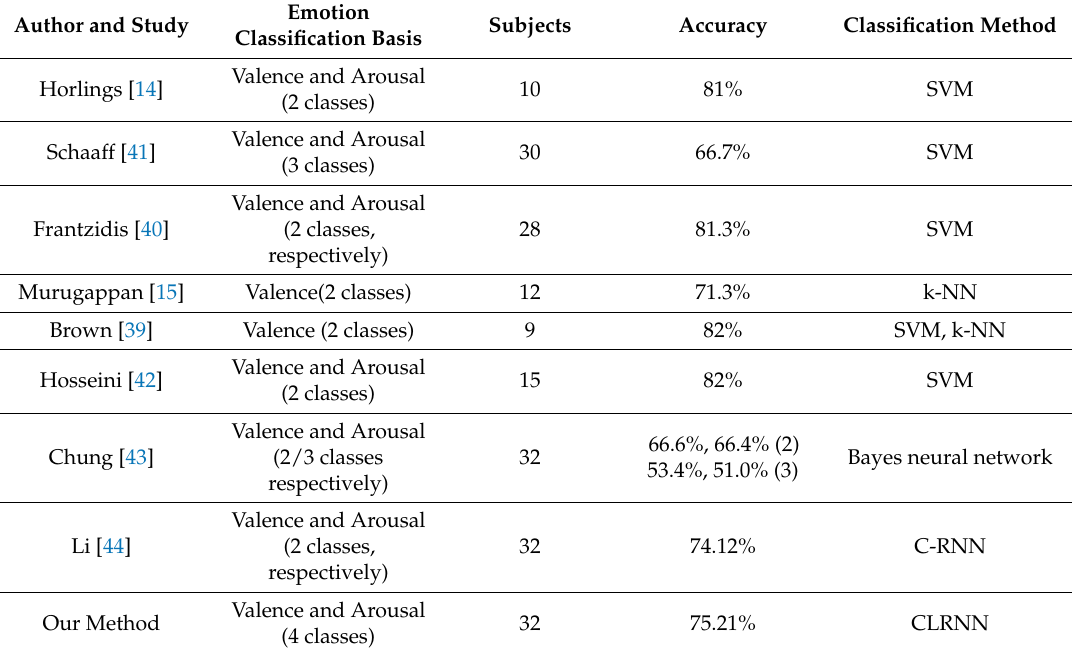
Table 2. Survey of the studies on emotion classification methods with EEG signal 1